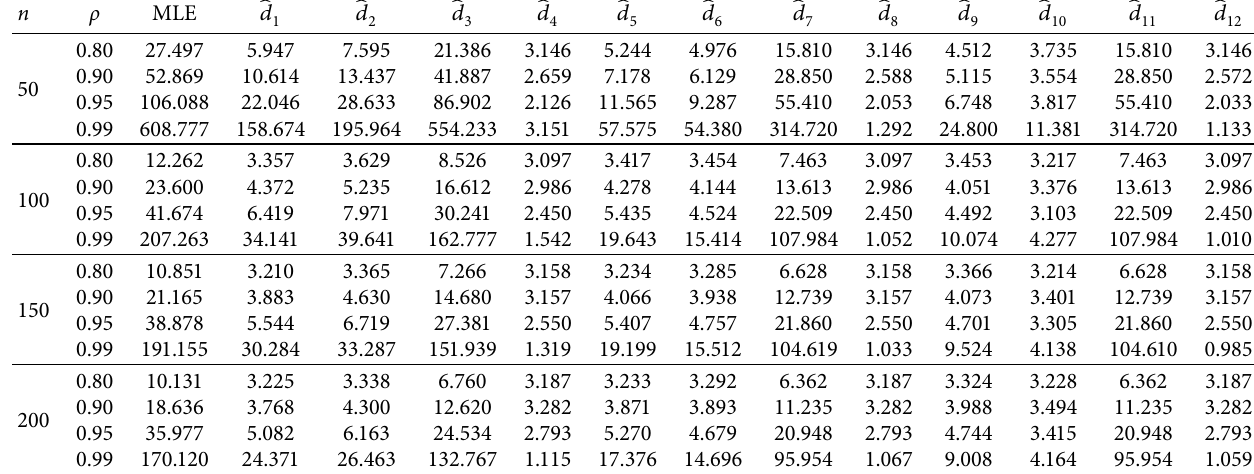
Table 10: Estimated MSEs of the COMPRM estimators, when p � 12 and ϑ � 0 . 85.